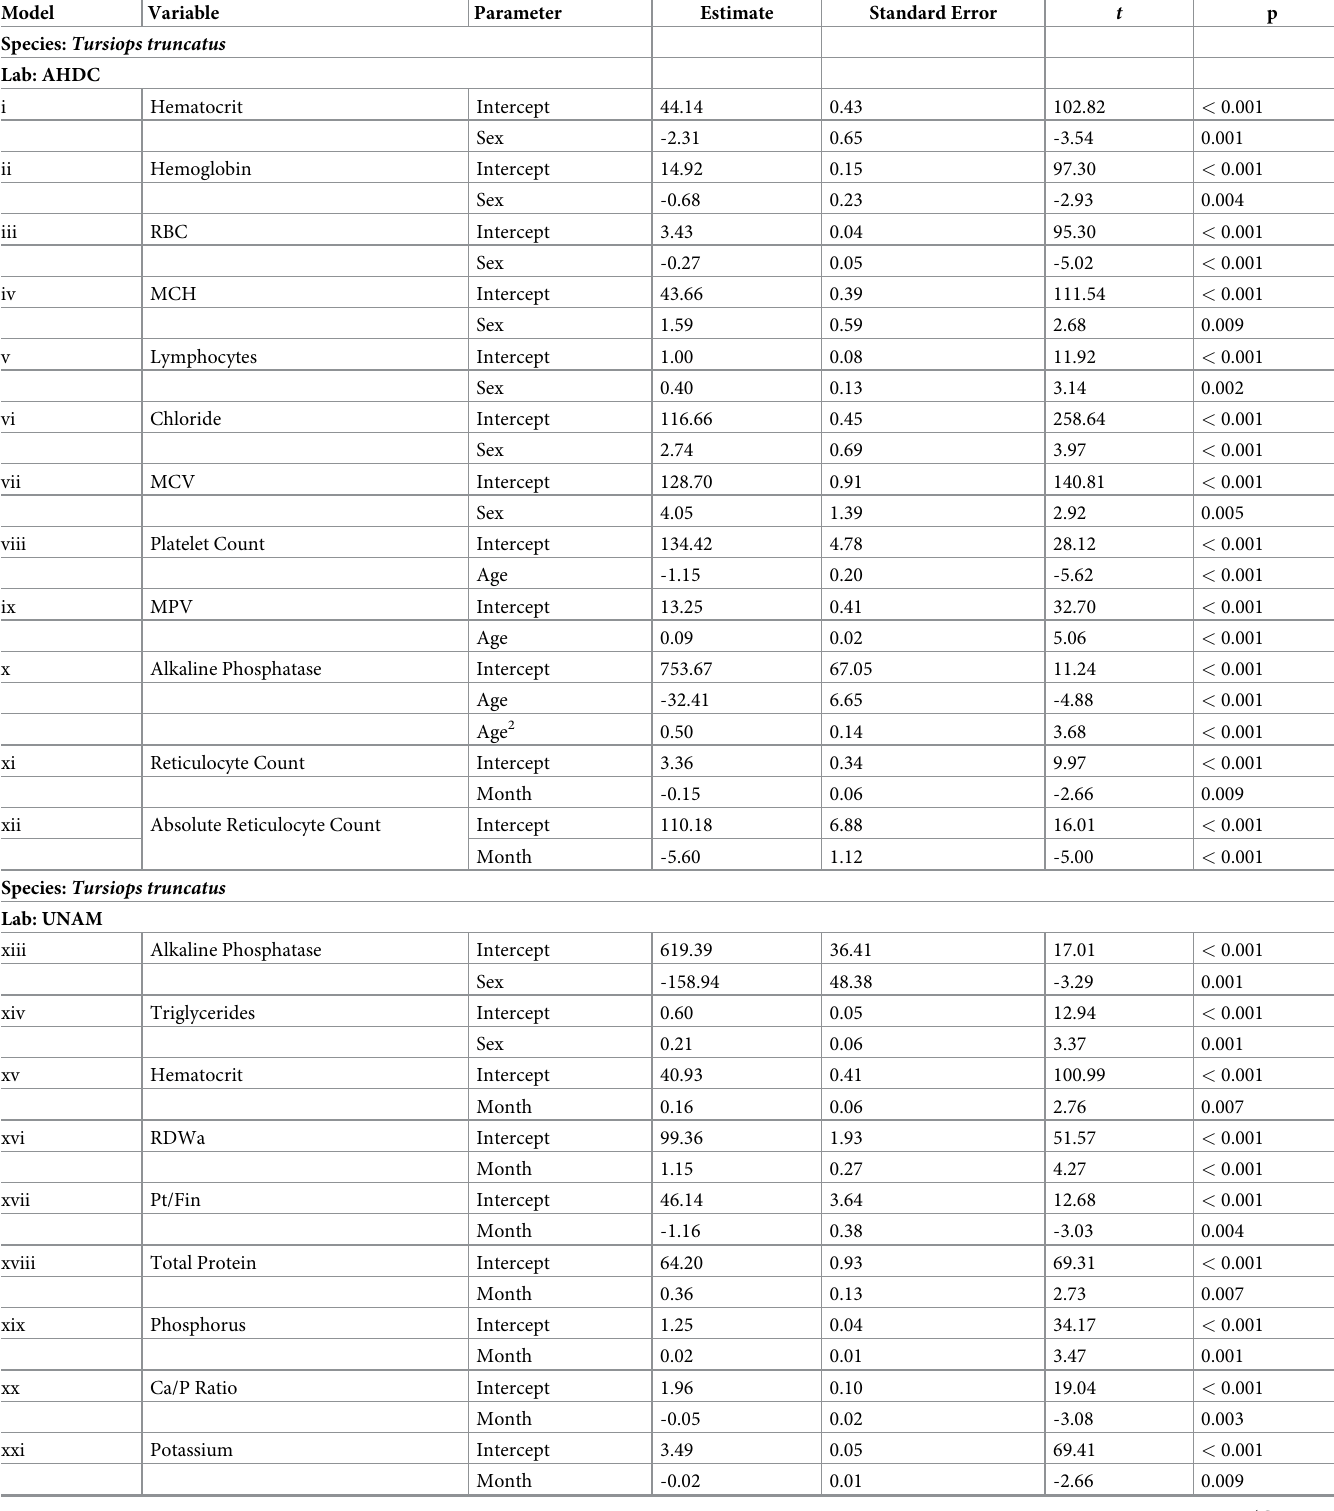
Table 3. Model estimates for predicting blood values.